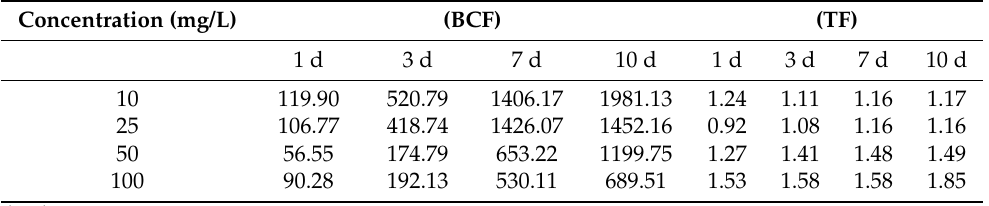
Table 4. Bioconcentration factor (BCF), and translocation factor (TF) for lead in Ludwigia stolonifera . Concentration